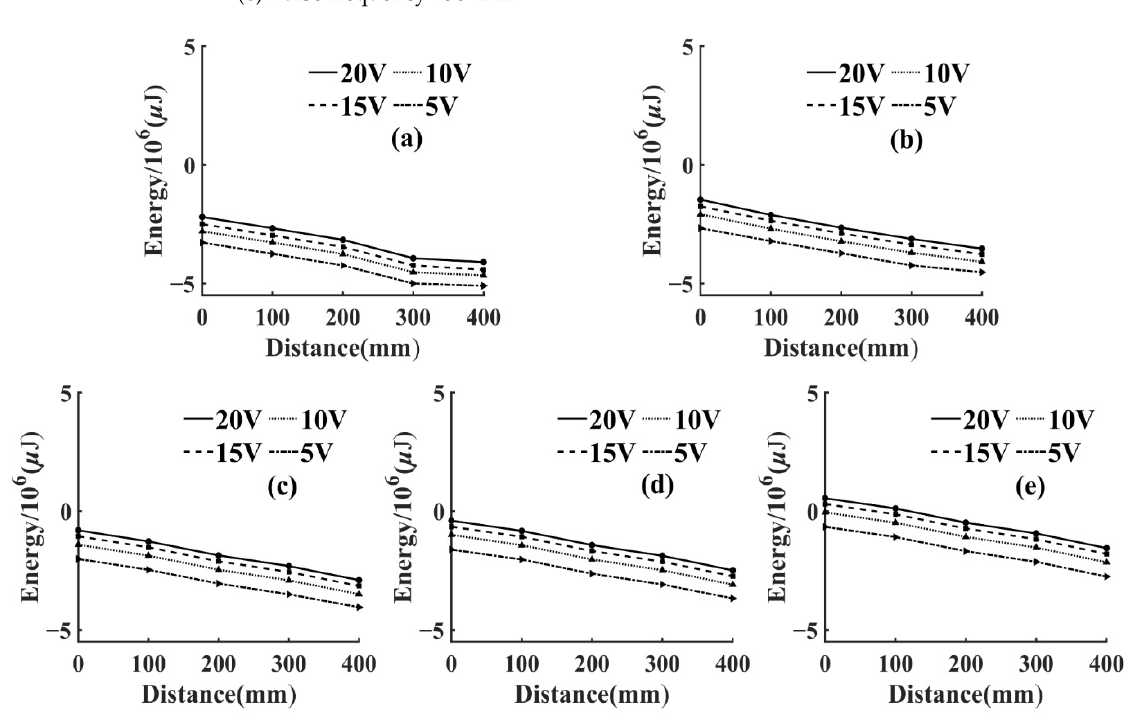
Figure 7. Variation of AE signal energy with propagation distance for T3 specimen. ( a ) Pulse fre-